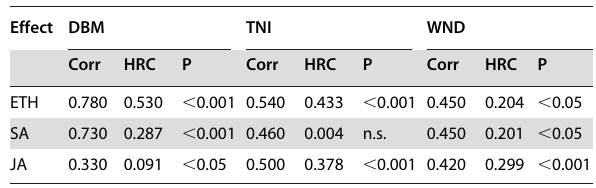
binding proteins of the LHCB1 and LHCB2 types, and genes encoding lipid-transfer proteins. In these cases, the level of sequence polymorphism also suggested that the clones were derived from different members of gene families. In other cases of highly abundant sequences, e.g. for a plant defensin, an elongation factor 1-alpha (EF-1 a ), a strictosidine synthase, or a vesicle- associated membrane family protein (VAMP), B. divaricarpa clones displayed no or very few differences, while the A. thaliana genome harbored several related genes. Finally, for a myrosinase-associ- ated protein (At3g14210), a glycine-rich protein (At3g07560), a protease inhibitor of the Kunitz family (At1g72290), a defective Table 3. Correlations (Corr) and Hormone Response Coefficients (HRC) between Causal (ETH, SA, JA) and